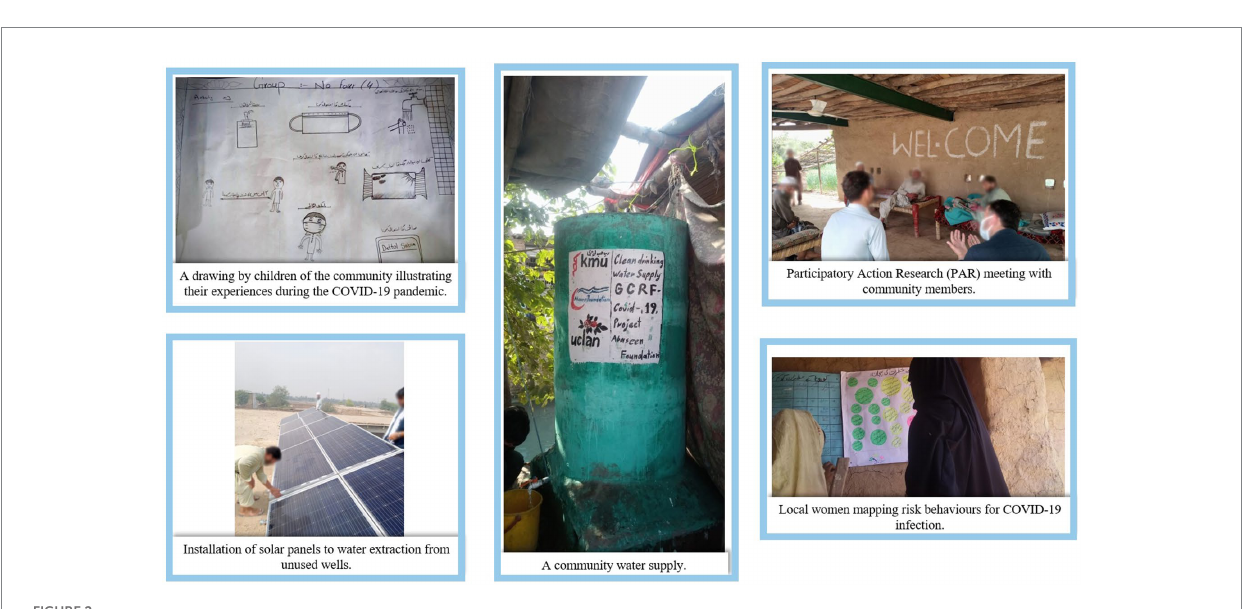
FIGURE 2 Photographs illustrating the different elements of the